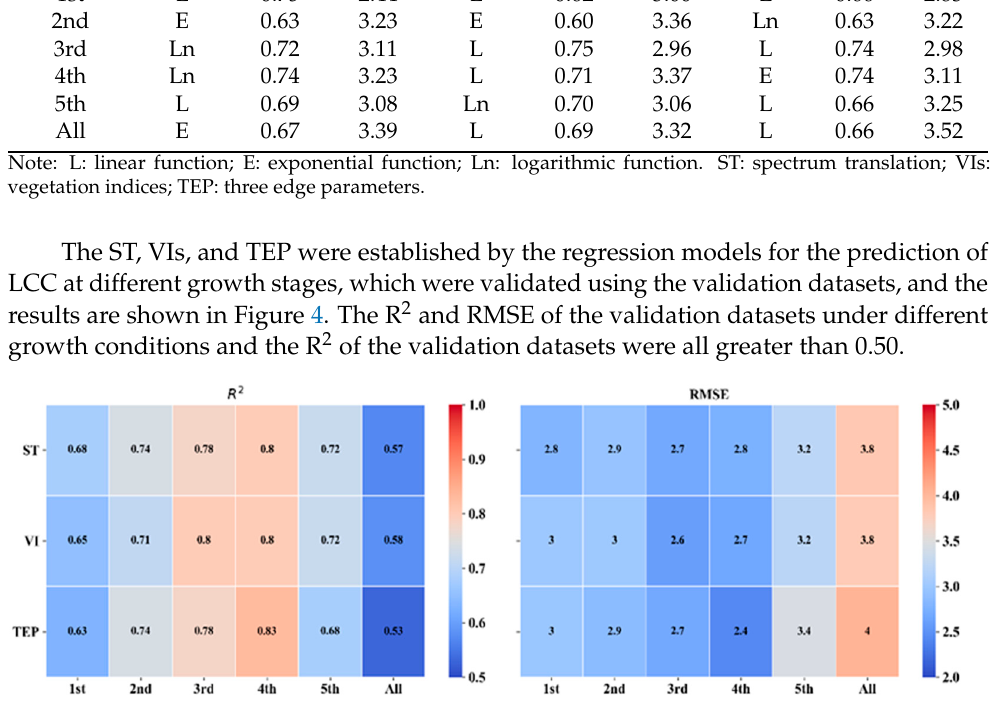
Table 5. Regression analysis and curve fitting results of three parameters versus LCC.